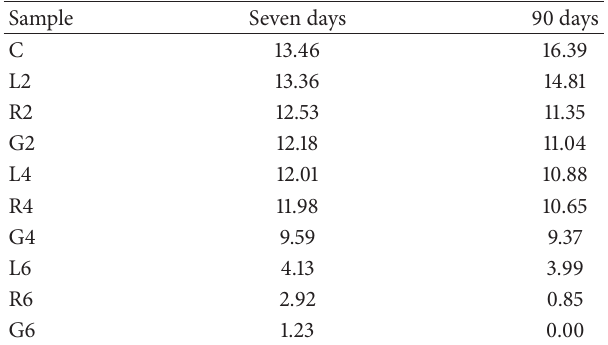
Table 4: Nonevaporating water content and hydration degree/mass, %.